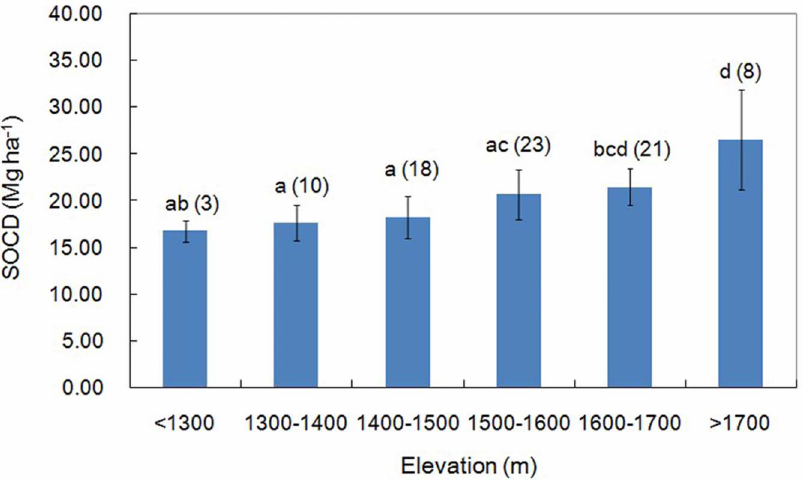
Figure 4. Relationship of elevation and topsoil SOCD. * The error bars are the standard errors of the mean of SOCD and values above the bars is the number of observations (in parentheses). A different letter means a difference significant at P , 0.05.